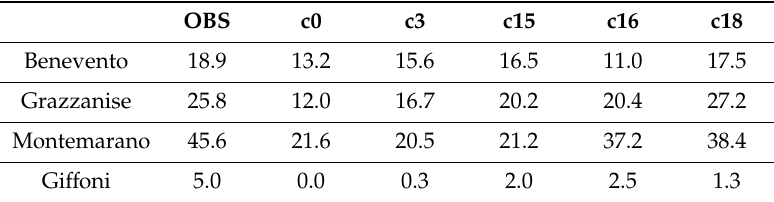
Table 10. Daily precipitation values (mm) for 20 November 2018 for specific ANCE stations, for observational value and model data (selected